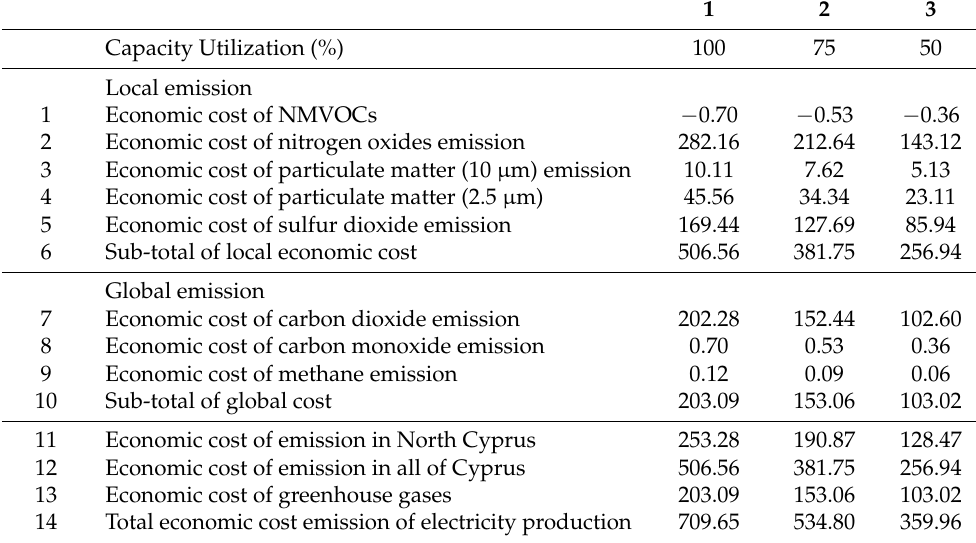
Table 5. Present value @ 8% emission costs for different levels of capacity utilization, ’000